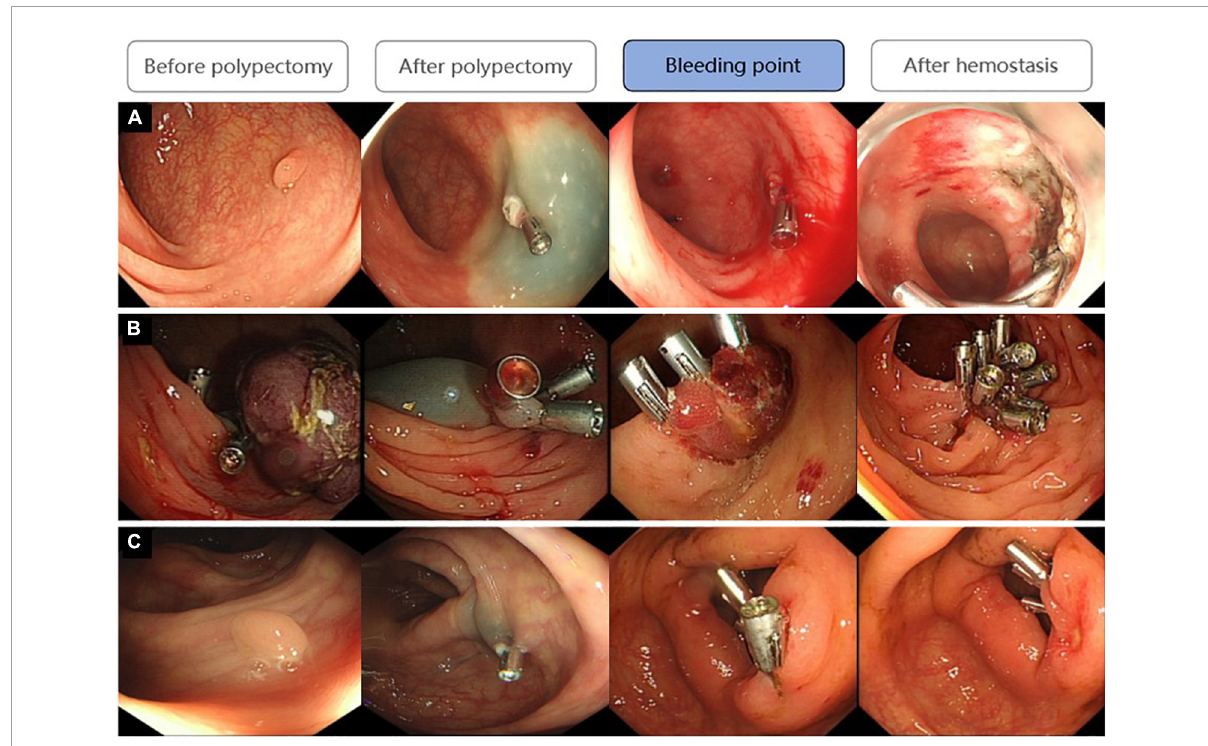
FIGURE8 Three states of bleeding points after DPPB: (A) Active bleeding; (B) Had formed blood clots or scabs covering the wound; (C) No obvious bleeding spot but some old bloodstain had been